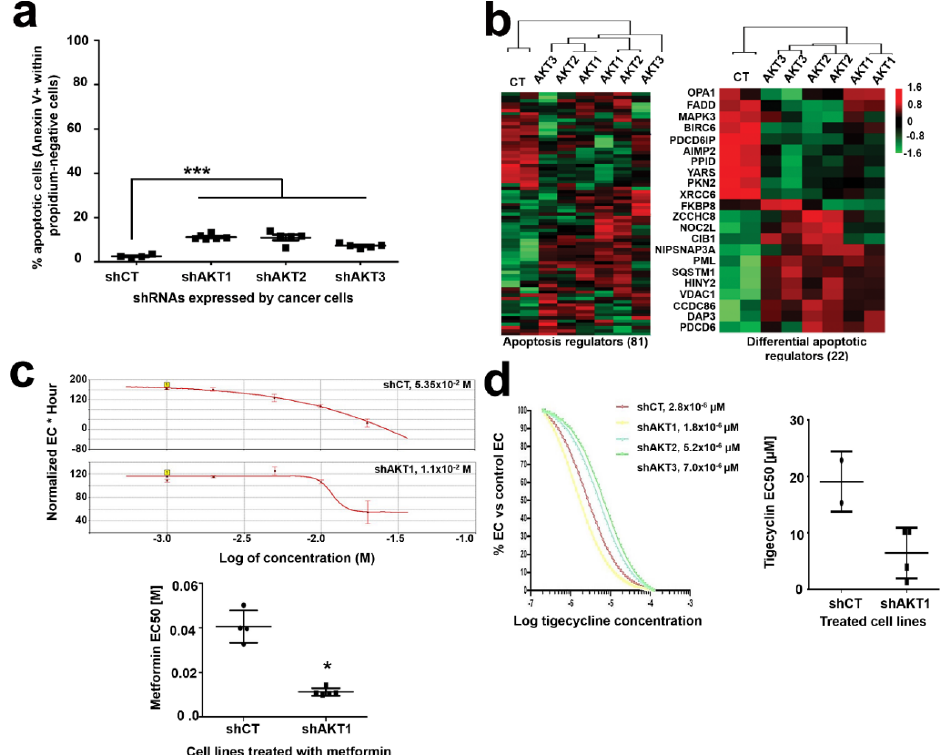
Figure 4. Pancreatic cancer cells with silenced AKT isoforms are sensitive to mitochondria-disrupting agents. ( a ) Dot plot representing the percentage of spontaneous apoptosis in the indicated cell lines. Relevant statistical comparisons are shown by ANOVA and pairwise Tukey´s test. Means and standard deviations are also shown. ( b ) Cluster analysis of proteins involved in regulation of apoptosis (left) and those significantly regulated (right) by silencing of the indicated AKT isoforms. ***, indicate highly significant ( p < 0.001) differences. ( c ) Top, RTCA EC 50 (effective concentrations) curves of metformin treatments for the indicated cell lines, four replicates per concentration. The calculated EC 50 s for each graph are shown within the graph. Bottom, dot plot graph of EC 50 values for metformin treatment calculated from five independent experiments as shown on top, in the indicated cell lines. The statistical comparison was performed with Student´s t test. ( d ) Left, RTCA EC 50 curves of tigecycline treatments for cell lines with the indicated AKT isoforms silenced, calculated by RTCA. The EC 50 values are shown. Right, dot plot graph of EC 50 values for tigecycline calculated from four experiments. *, ***, indicate significant ( p < 0.05) and highly significant ( p < 0.001) differences. ALDH activity has been established as a factor responsible for CSC survival, differentiation and resistance to chemo- and radiotherapy. High ALDH1A1 activity has been shown to correlate with CSC phenotype in different cancer types [21]. As our proteomic data show ALDH2 upregulation in cells adapted to AKT1 silencing compared to the other cell lines including the shCT control, we assessed the expression of both ALDH1A1 and ALDH2 by Western blot by loading equal amounts of cells per sample. Interestingly, ALDH1A1 was overexpressed in cells adapted to AKT3 silencing, while high ALDH2 levels were maintained both in cells adapted to AKT1 silencing and control cells (Figure 5f). Nevertheless, ALDH expression levels do not fully correlate with high enzymatic activity as these enzymes can be inhibited by post-translational modifications such as acetylation [22]. Therefore, ALDH activity was quantified in each cell line by flow cytometry using Aldefluor kit (Figure 5g). Interestingly, although there was high variability between experiments, cells adapted to silencing of AKT isoforms showed higher ALDH activities than control cells.